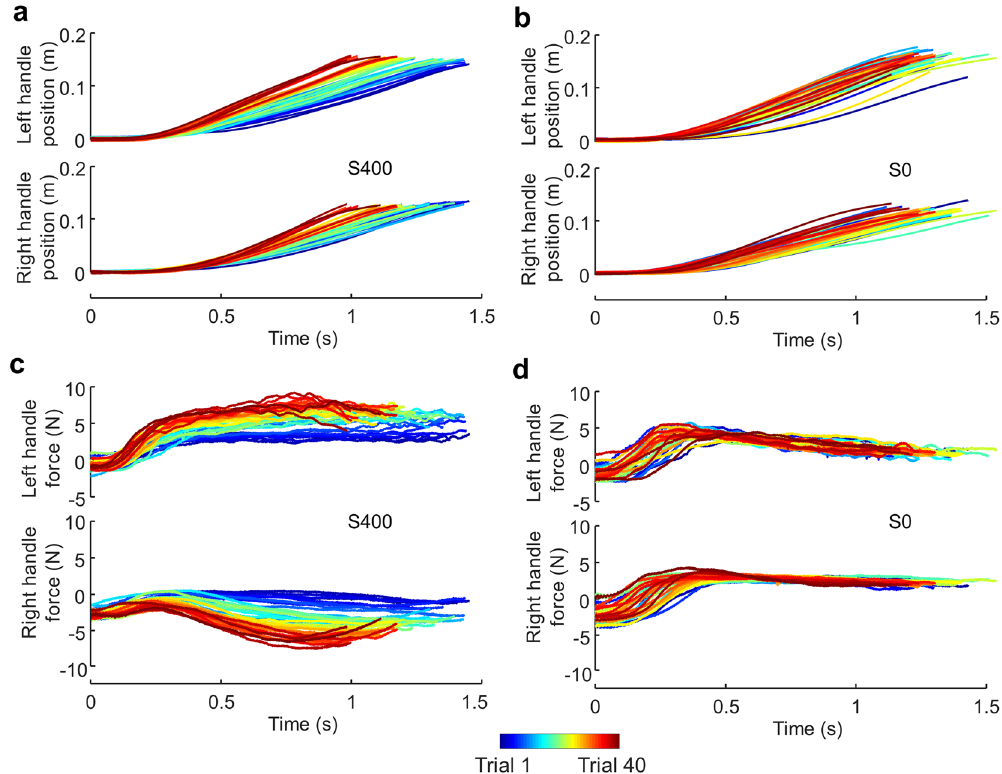
Figure 2. Changes in motor behavior of paired individuals across successful trials. Early trials are plotted as blue traces, and subsequent trials are denoted by ’warmer’ colors. ( a ) Left and right handle movements performed by a representative dyad in the S400 condition. ( b ) Hand movement performed by a different representative dyad in the S0 condition. ( c ) Measured left and right handle force from the same dyad shown in ( a ). ( d ) Measured handle force from the same dyad shown in ( b ). Rainbow-like color distributions in ( a ) and ( c ) clearly indicate consistent changes of behavior across trials in the S400 condition, whereas intermingled color distributions in ( b ) and ( d ) indicate no such consistent changes for the S0 condition. Each plot shows data from 40 successful